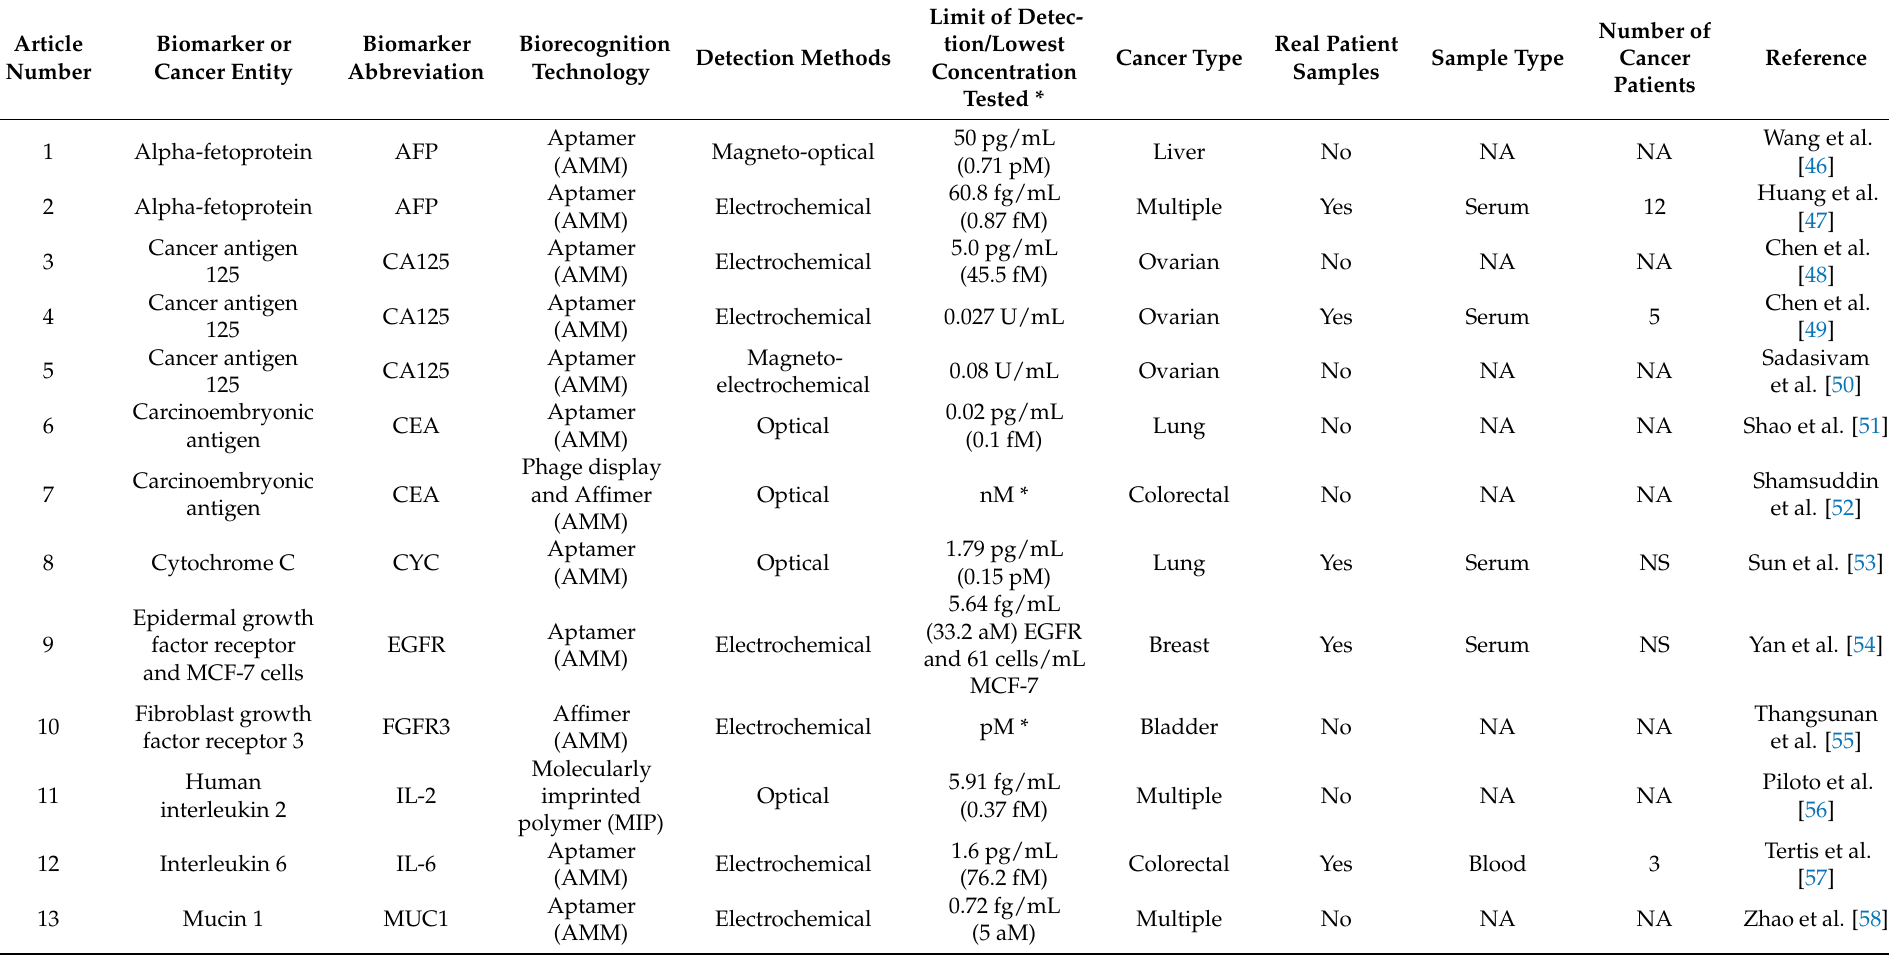
Table 6. Applications of biorecognition engineering technologies in cancer biosensors from Web of Science from 2019 to 2021 (up to 10 December